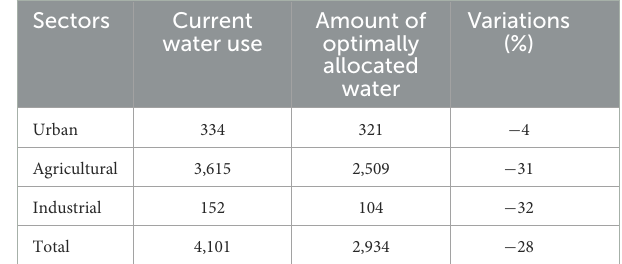
TABLE 5 The allocation of water among different sectors (unit: million m 3 ).